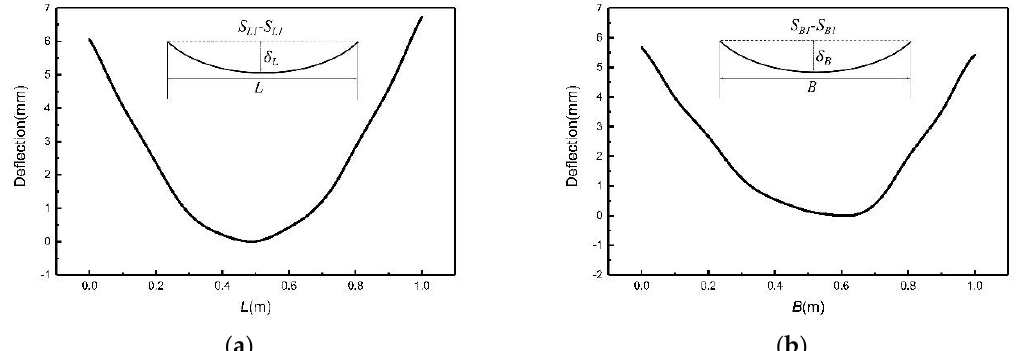
Figure 18. Deflection of a formed pillow-type plate: ( a ) deflection of the S L 1 -S L 1 and ( b ) deflection of the S B 1 -S B 1 .